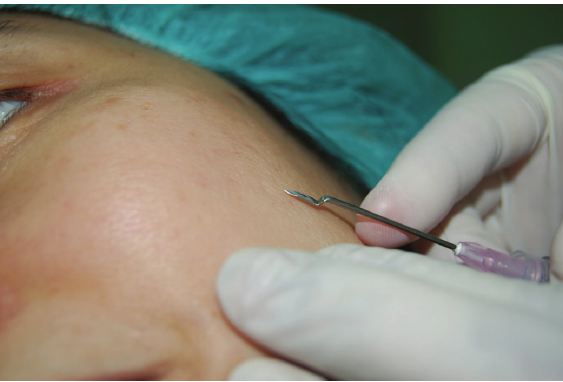
Figure 3: The parallel alignment of the needle to the skin surface conforms an ergonomic motion while serving the purpose of the final configuration of the needle, that is, preventing penetration of the skin beyond the scar and maintain a horizontal orientation of the needle